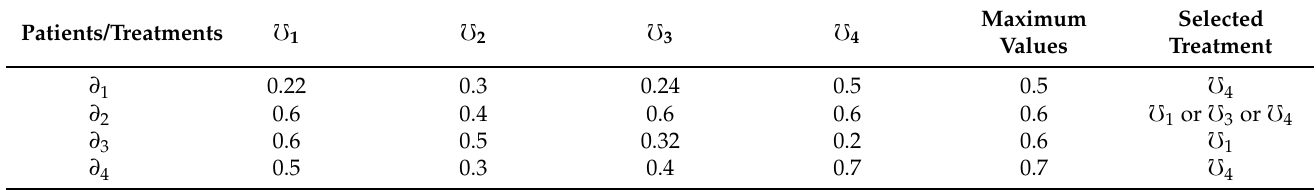
Table 14. Data pertaining to suggested treatment is represented in a tabular